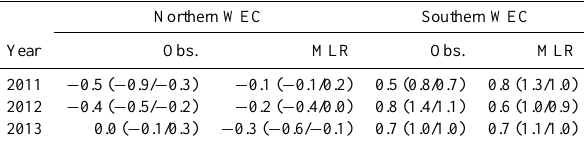
Table 3. Air–sea CO 2 fluxes (in molCm − 2 yr − 1 ) calculated from observed p CO 2 and from p CO 2 obtained by MLR along the ferry track in nWEC and sWEC using Nightingale et al. (2000) k param- eterization. In the main text and figures, all these fluxes are given with their respective uncertainties as computed in Sect. 3.5. Here we provide in brackets values computed using Wanninkhof et al. (1992) and Wanninkhof and McGillis (1999) k parameterizations to give a range of computed air–sea CO 2 fluxes.